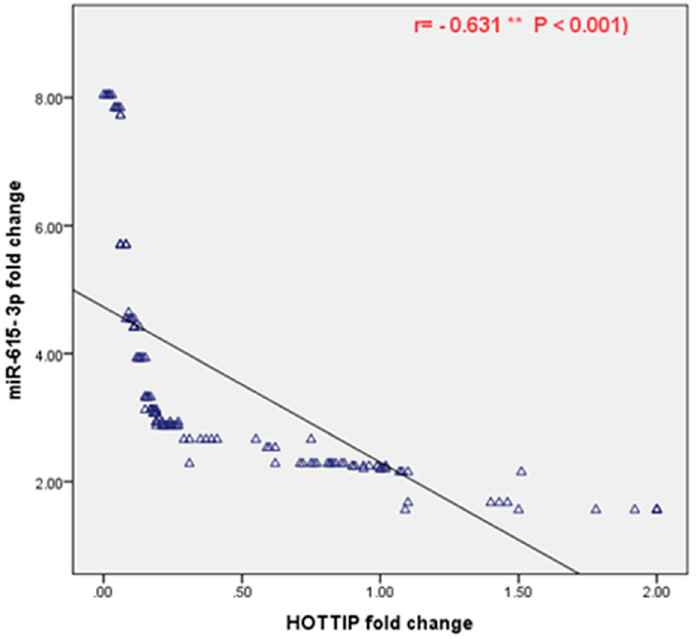
Figure 3. Spearman correlation between the HOTTIP and miR-615-3p serum expression levels in patients with BC. ** Significant at p < 0.001.